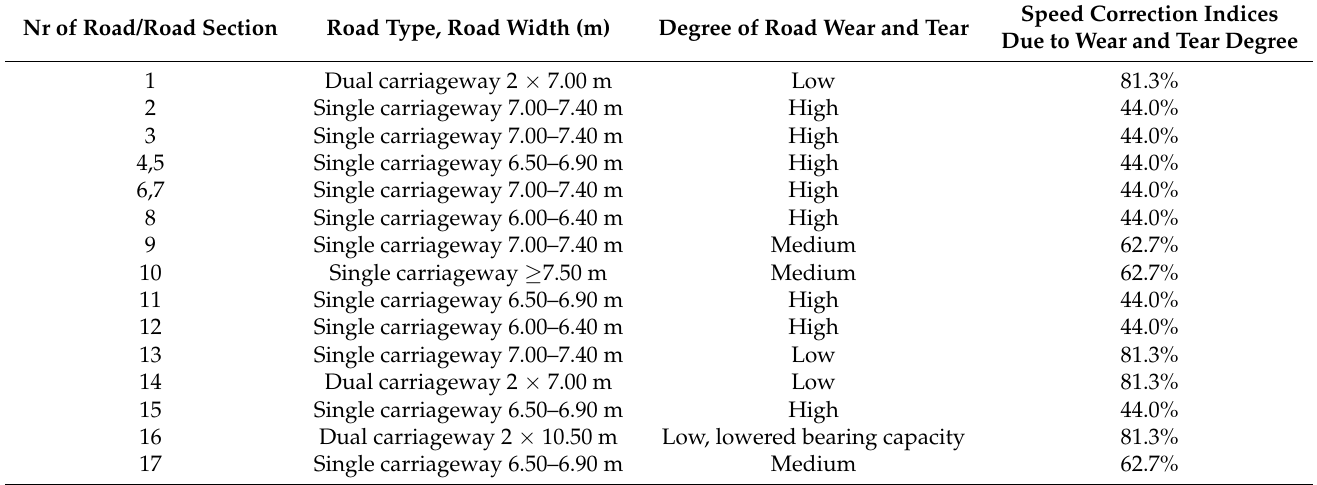
Table 2. Degree of roads wear and tear estimation with corresponding speed correction indices. Nr of Road/Road